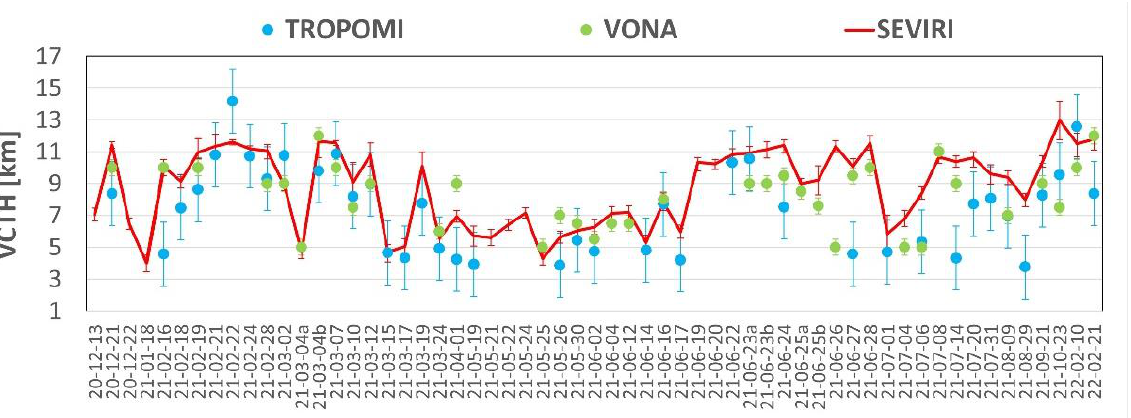
Figure 11. Cross-comparison between the VCTH obtained from SEVIRI as the weighted mean of the DP, CT, and HY procedures, TROPOMI SO 2 altitude, and VONA reports. The error bars represent the height uncertainties of the three sensors. The “Date” labels ( x -axis) are in the format year-month-day, with letters a and b to distinguish the LFs that occurred on the same day.